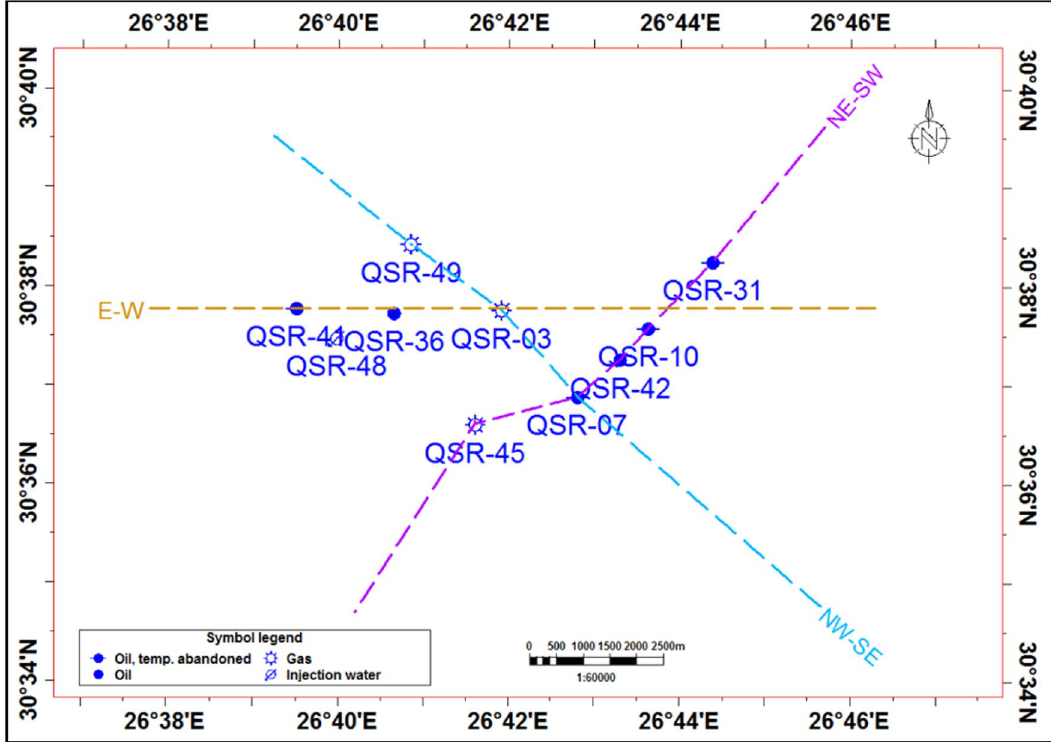
Fig. 2 Location map of Qasr field showing wells and seismic